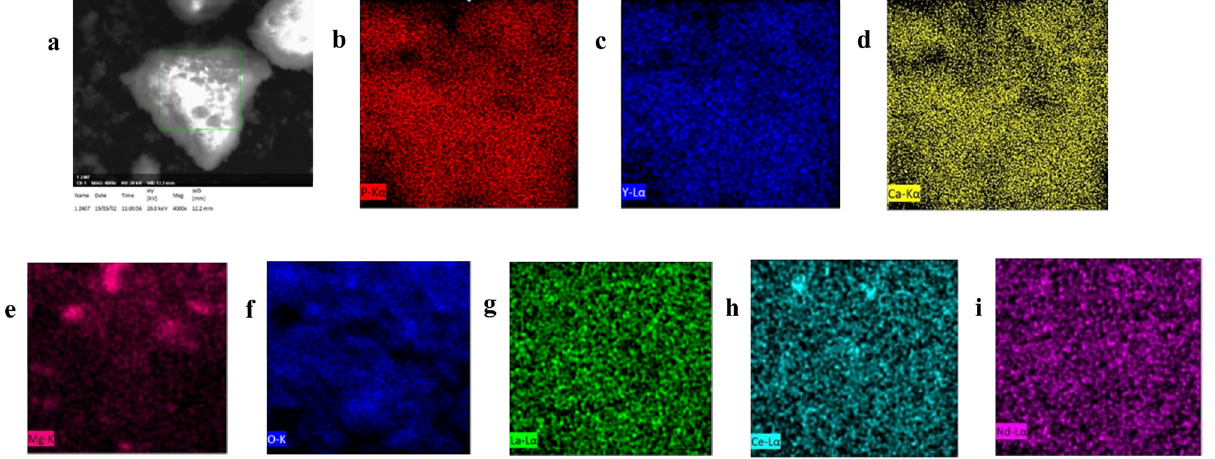
Figure 1: SEM - EDS image of a fl uorapatite particle from which EDS elemental maps were obtained; ( a ) was a SEM image for fl uorapatite particle; ( b – i ) were elemental maps for P, Y, Ca, Mg, O, La, Ce, and Nd,